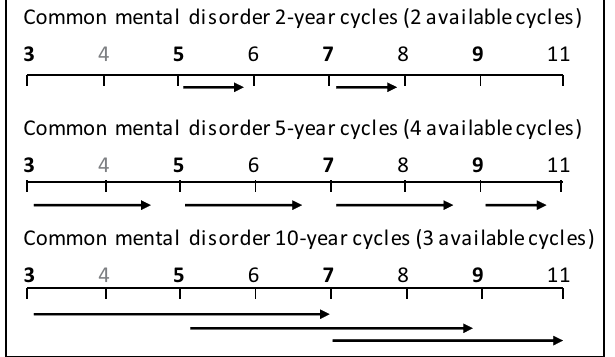
Figure 1. Modes of analysis using cycle approach for common mental disorder a . Numbers indicate study phases. Phases with food frequency data in bold; no data on common mental disorder available at Phase 4. a Common mental disorder measured using the 30-item General Health